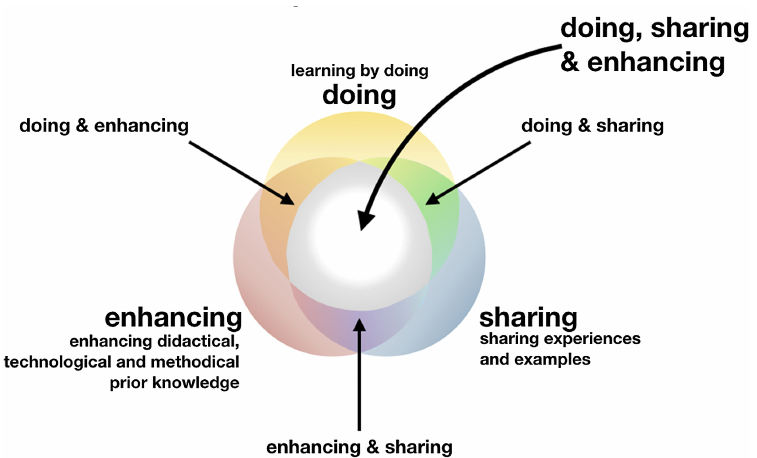
Figure 5. DSE model of